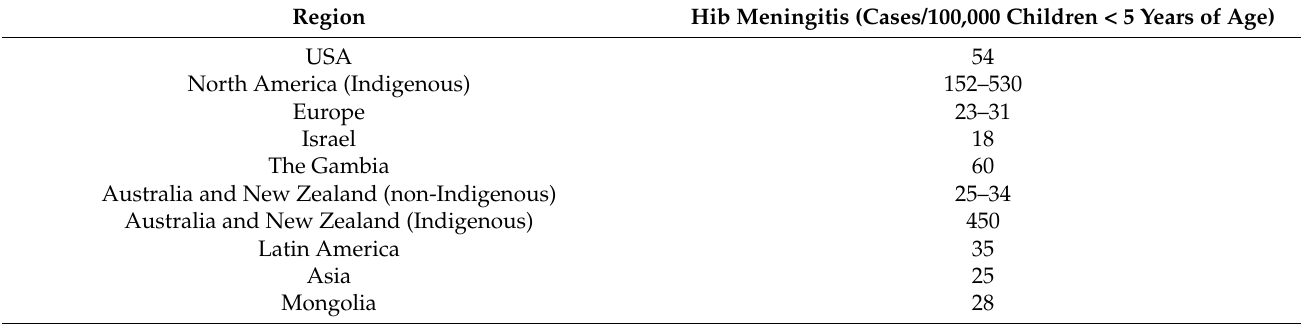
Table 1. Incidence of Hib meningitis before the introduction of routine Hib conjugate vaccination. Region Hib Meningitis (Cases/100,000 Children < 5 Years of